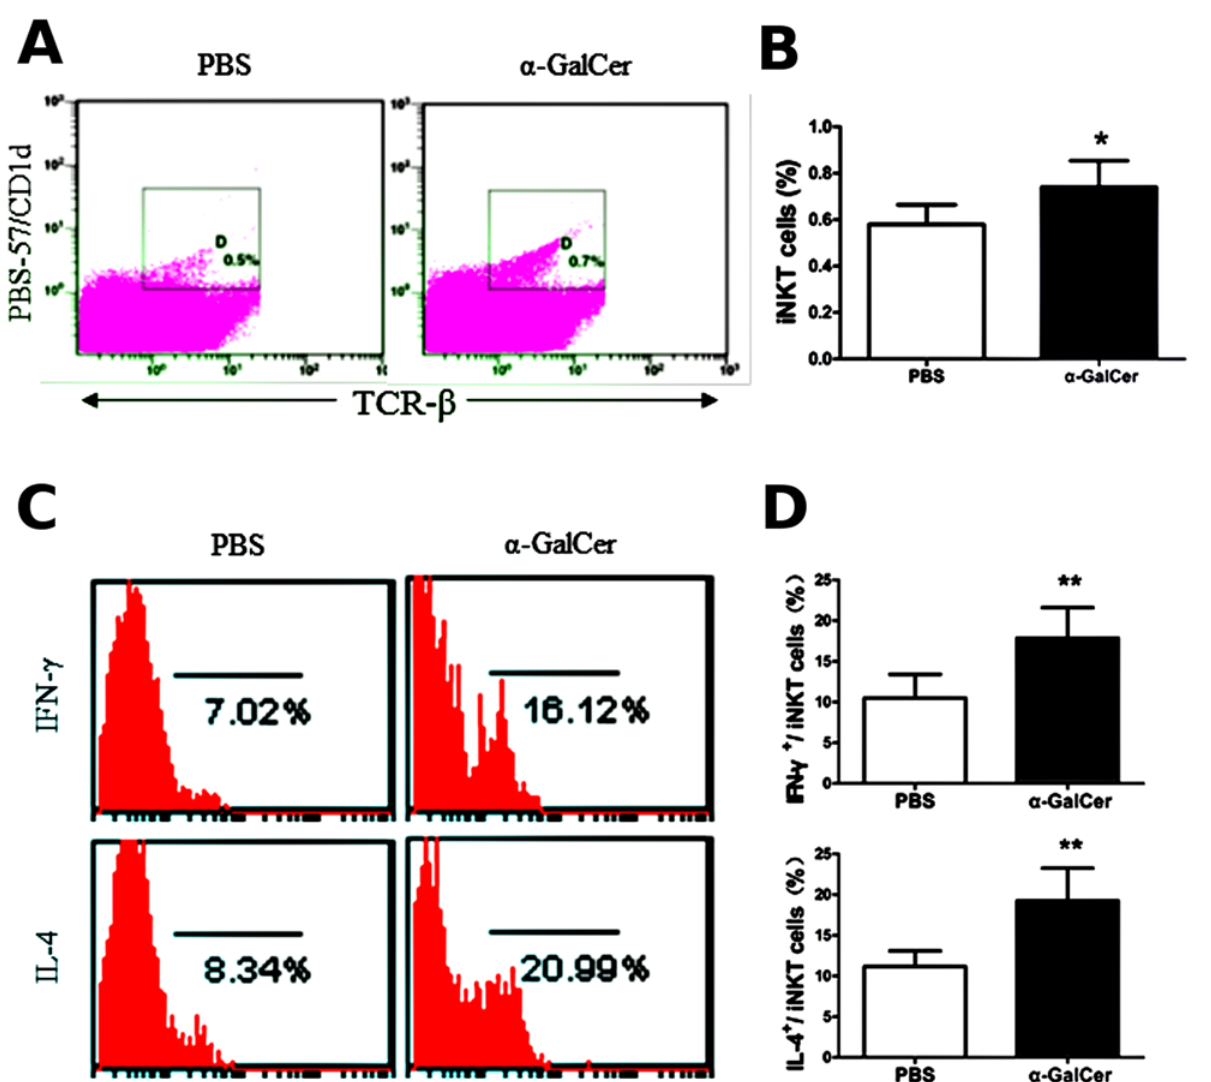
Fig 1. α -GalCer administration activates iNKT cells in wild-type (WT) mice. A . Lung iNKT cells were confirmed by PBS/CD1d tetramers and TCR- β staining in WT mice treated with α -GalCer or PBS using flow cytometry. The gating used for iNKT cells (PBS-57/CD1d tetramers + TCR- β + ) (gate D) and the corresponding percentages are shown in each dot plot. B . Percentage of iNKT cells in lung MNCs from WT mice treated with α -GalCer or PBS. N = 5 per group and * P < 0.05. C . Lung iNKT cells producing IFN- γ and IL-4. PBS-57/CD1d and TCR- β double-positive cells were examined for IFN- γ (top) and IL-4 (bottom) secretion. The numbers below the parentheses indicate the percentage of positive cells. D . Percentage of IFN- γ - and IL-4-expressing iNKT cells in the lung. N = 5 per group and ** P < 0.01.